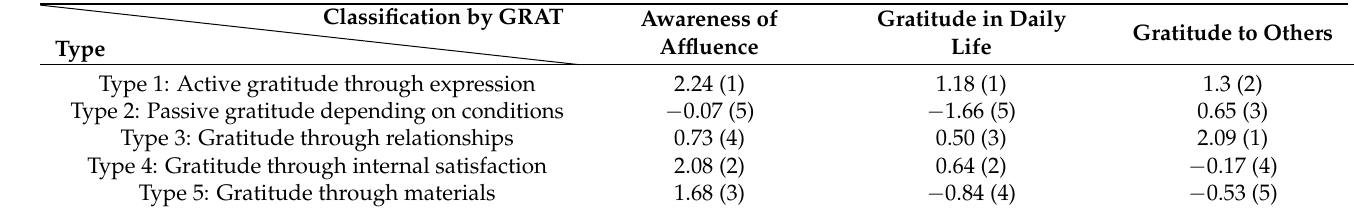
Table 13. Sums of Z-Scores (Ranking) of Q Statement Classified by GRAT’s Gratitude